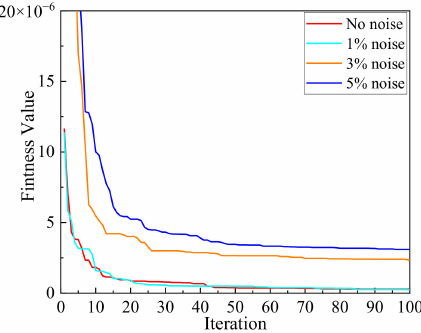
Figure 8. The iterative curves for the ASCE benchmark frame.